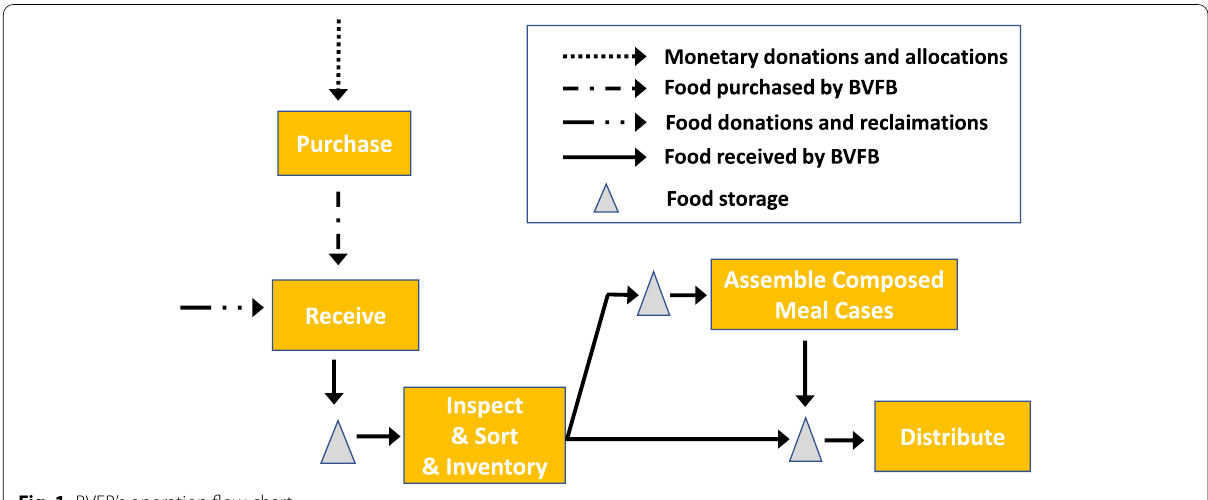
Fig. 1 BVFB’s operation flow